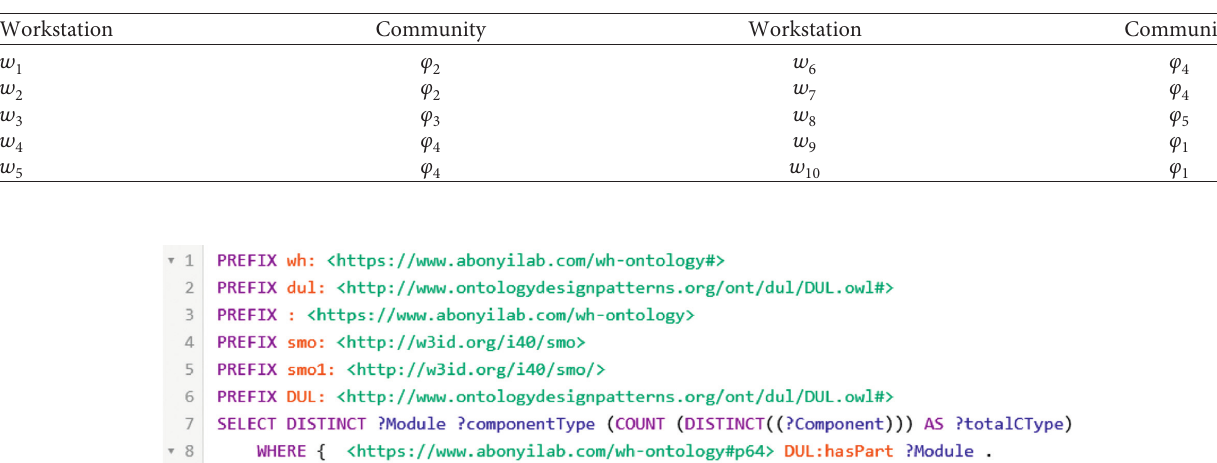
Figure 20: Activity-workstation layer and the identified communities. Table 4: The distribution of workstations into five different communities.